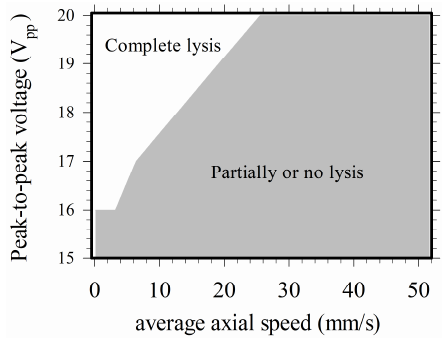
Figure 5. Map for electrical cell lysis in the present device for 16–20 V pp and u av = 1.3–51.7 mm/s.